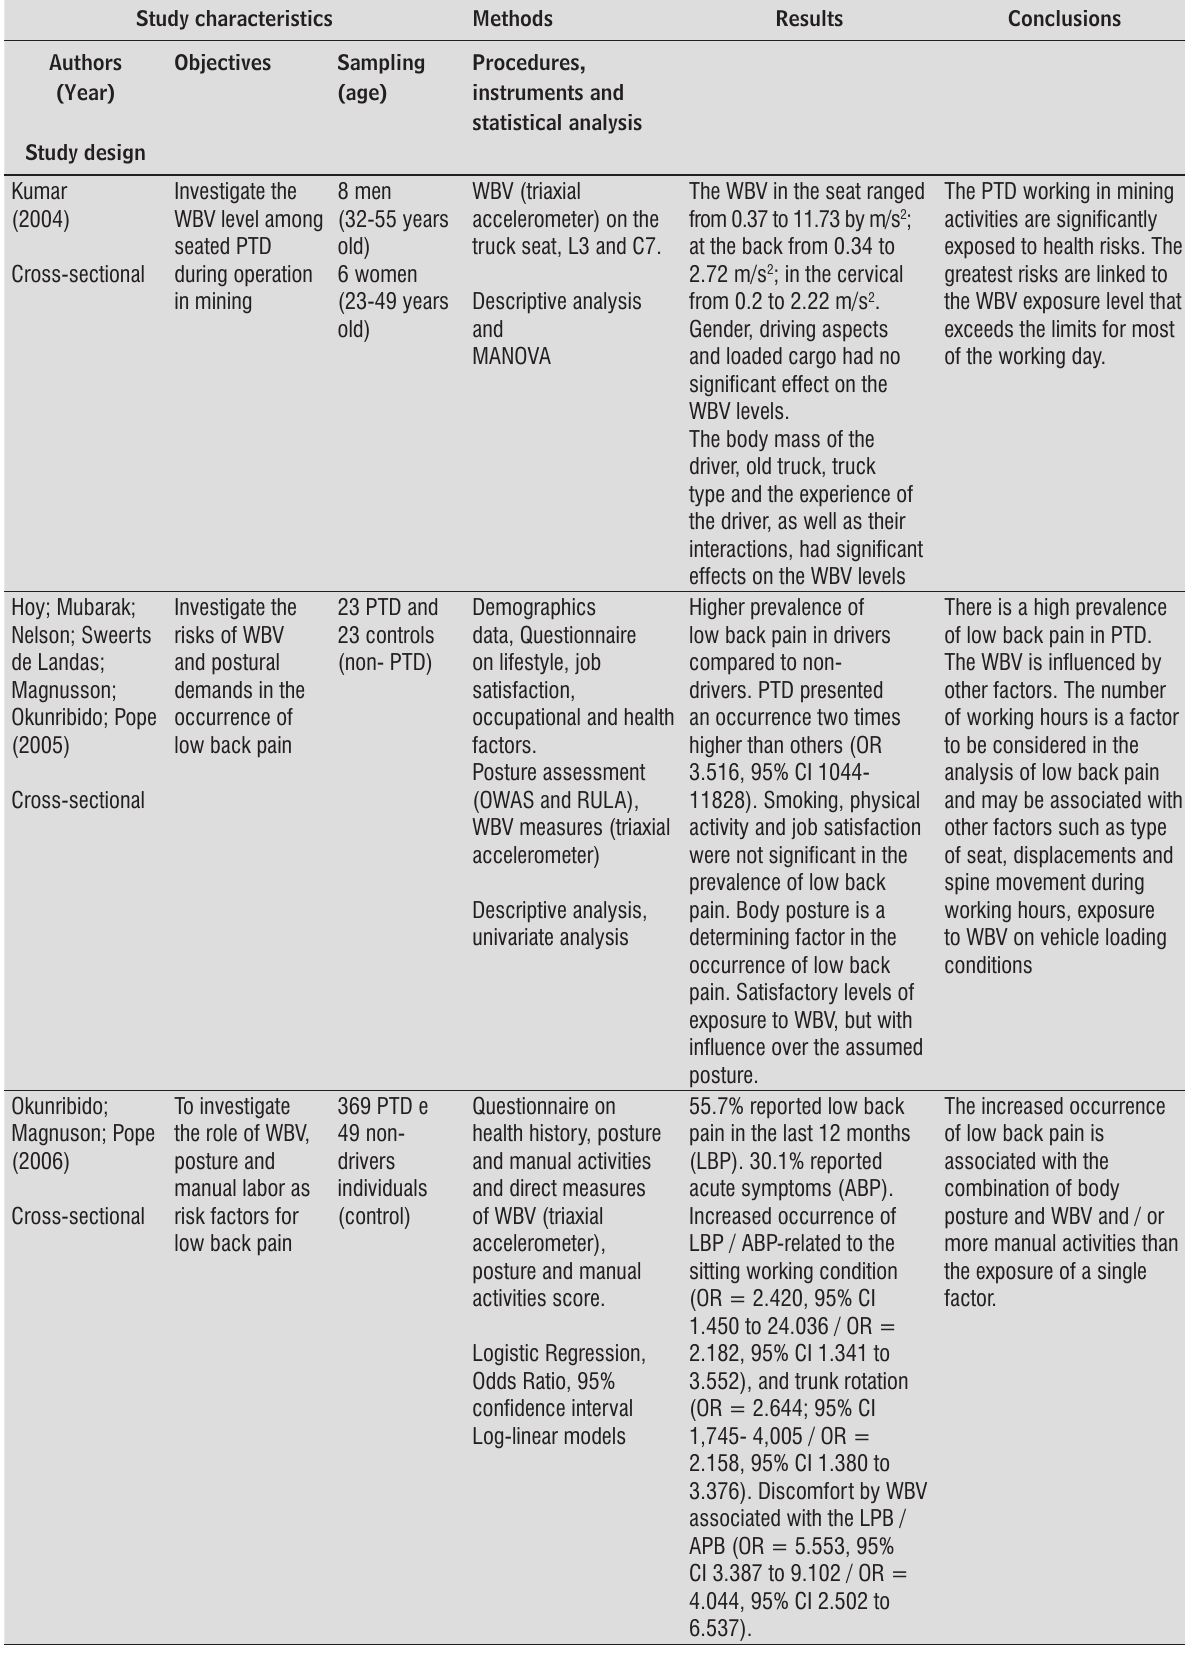
Table 3 - Characteristics of the articles selected for systematic